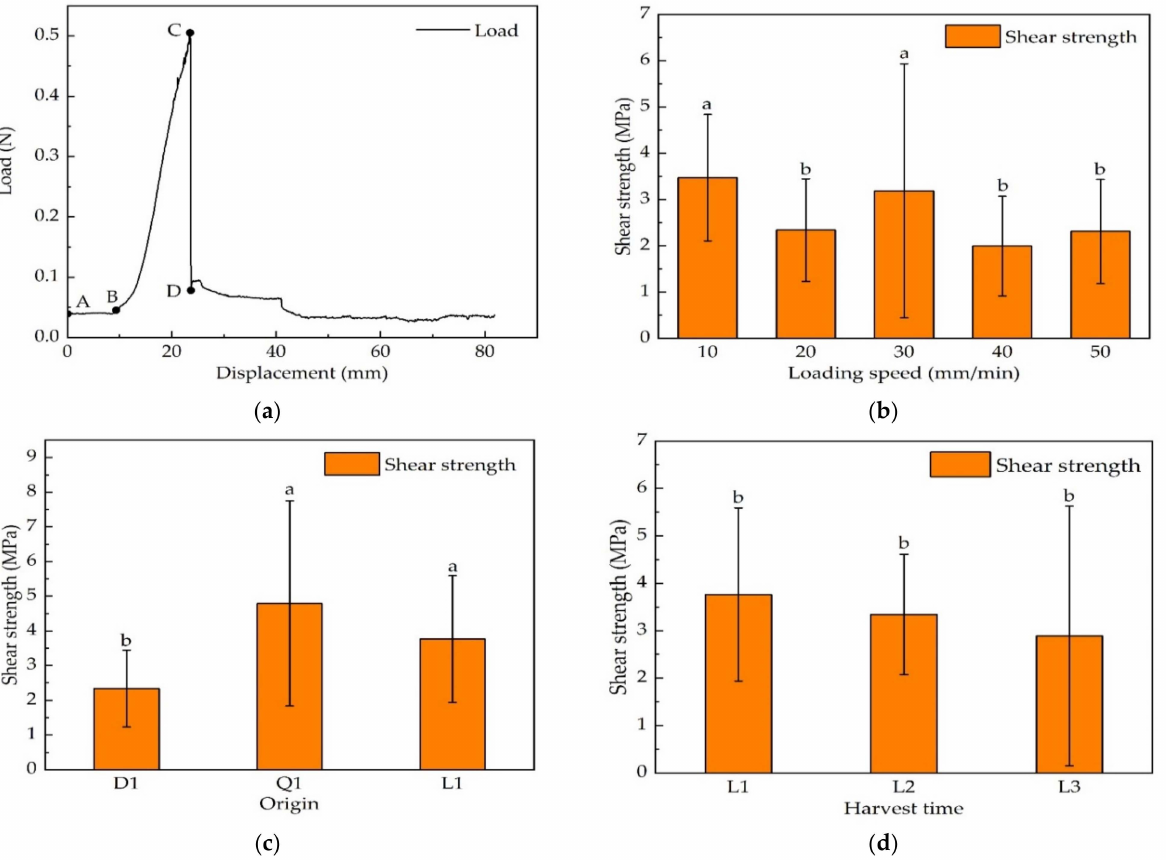
Figure 8. Shear properties of laver: ( a ) the load–displacement curve of the shear test of laver; ( b ) the effect of loading rate on shear strength; ( c ) the effect of origin on shear strength; ( d ) the effect of harvest time on shear strength. The different lowercase letters indicate a significant difference between groups ( p < 0.05), while same lowercase letters indicate no significant difference between groups ( p >